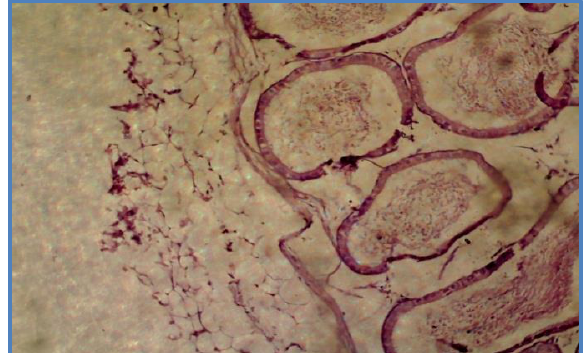
Figure, 7: Cross section of the rat epididymis of control group showing normal structure (H and E stain 10x).